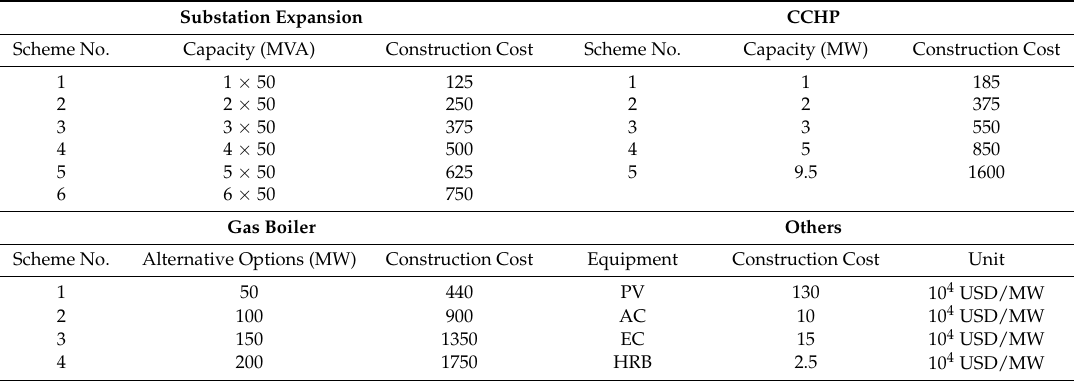
Table 1. Alternative planning options for the energy supply equipment. Combined cooling, heating, and power unit (CCHP), photovoltaic (PV), absorption chiller (AC), electric chiller (EC), heat recovery boiler (HRB); USD: US